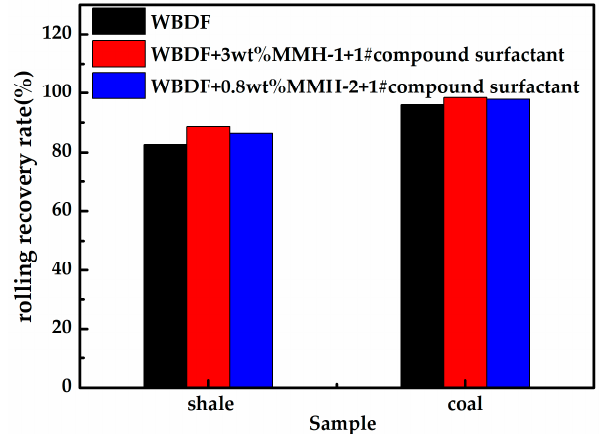
Figure 10. Effect of different drilling fluids on rolling recovery rates of the Longmaxi shale and the Longtan coal. Note: The formula of 1# compound surfactant is 0.001 wt% CS-4 + 0.001 wt% CS-1 + 0.001 wt% CS-3. The same as follows.